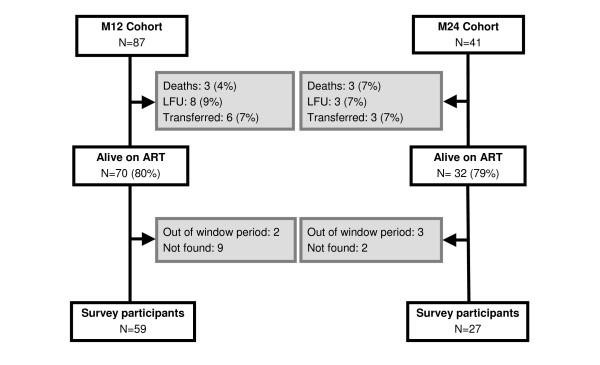
Cohort profiles, Arua, Uganda, 2006.